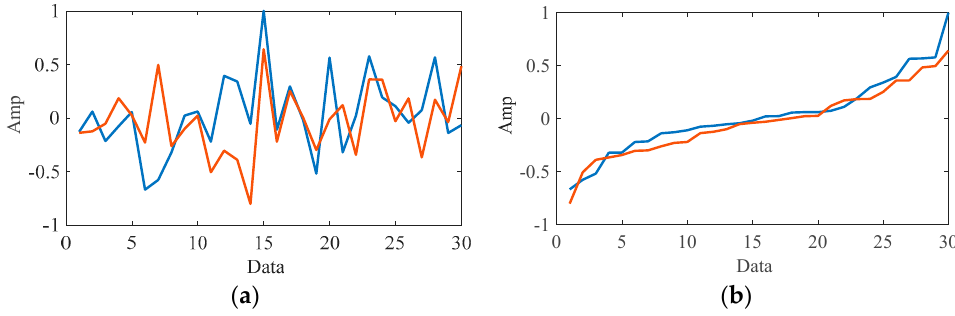
Figure 4. Numerical simulation. ( a ) Random amplitude curves; ( b ) sorted amplitude